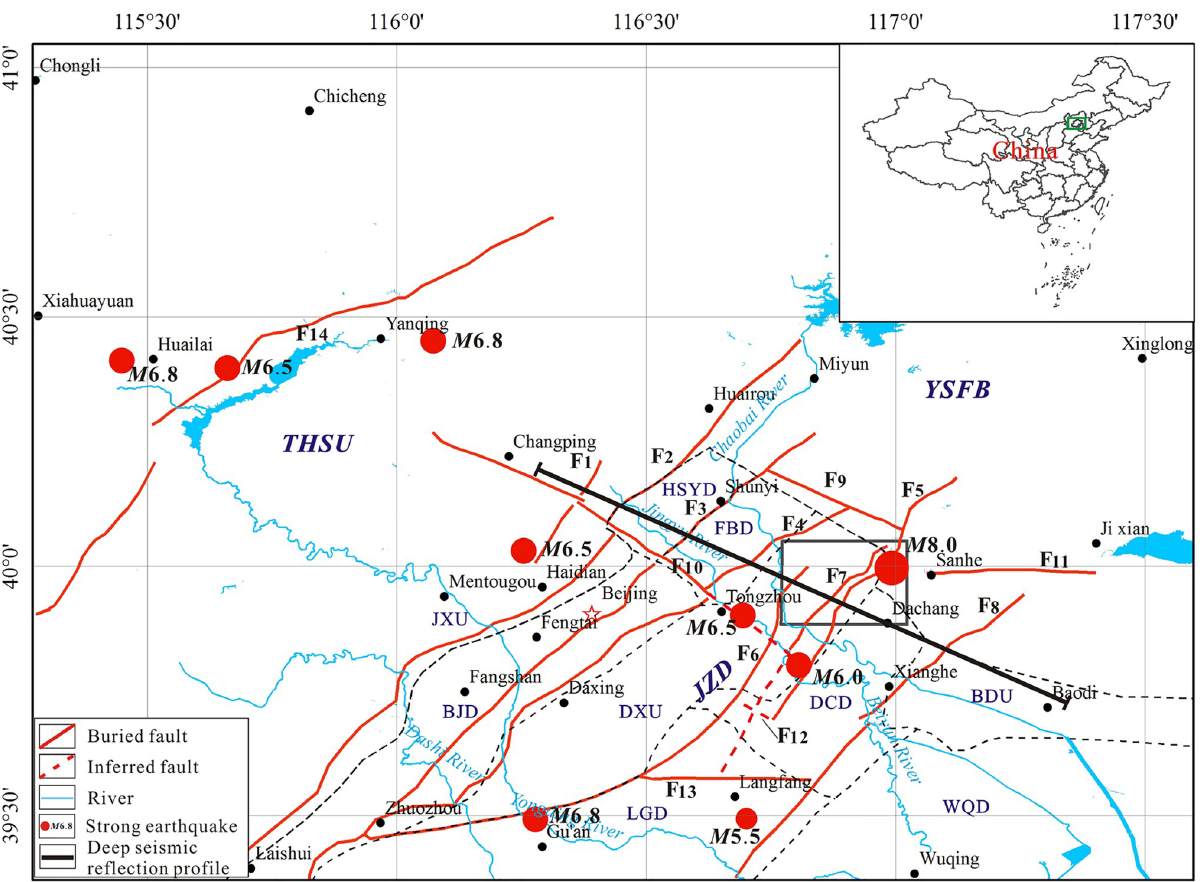
Fig 1. Location and buried faults distribution of the study area. The distribution of the faults is adapted from He et al. [28]. The tectonic units and their boundary are adapted from Gui et al. [33]. The seismicity data are from the China Earthquake Networks Center (CENC). F1 Xiaotangshan